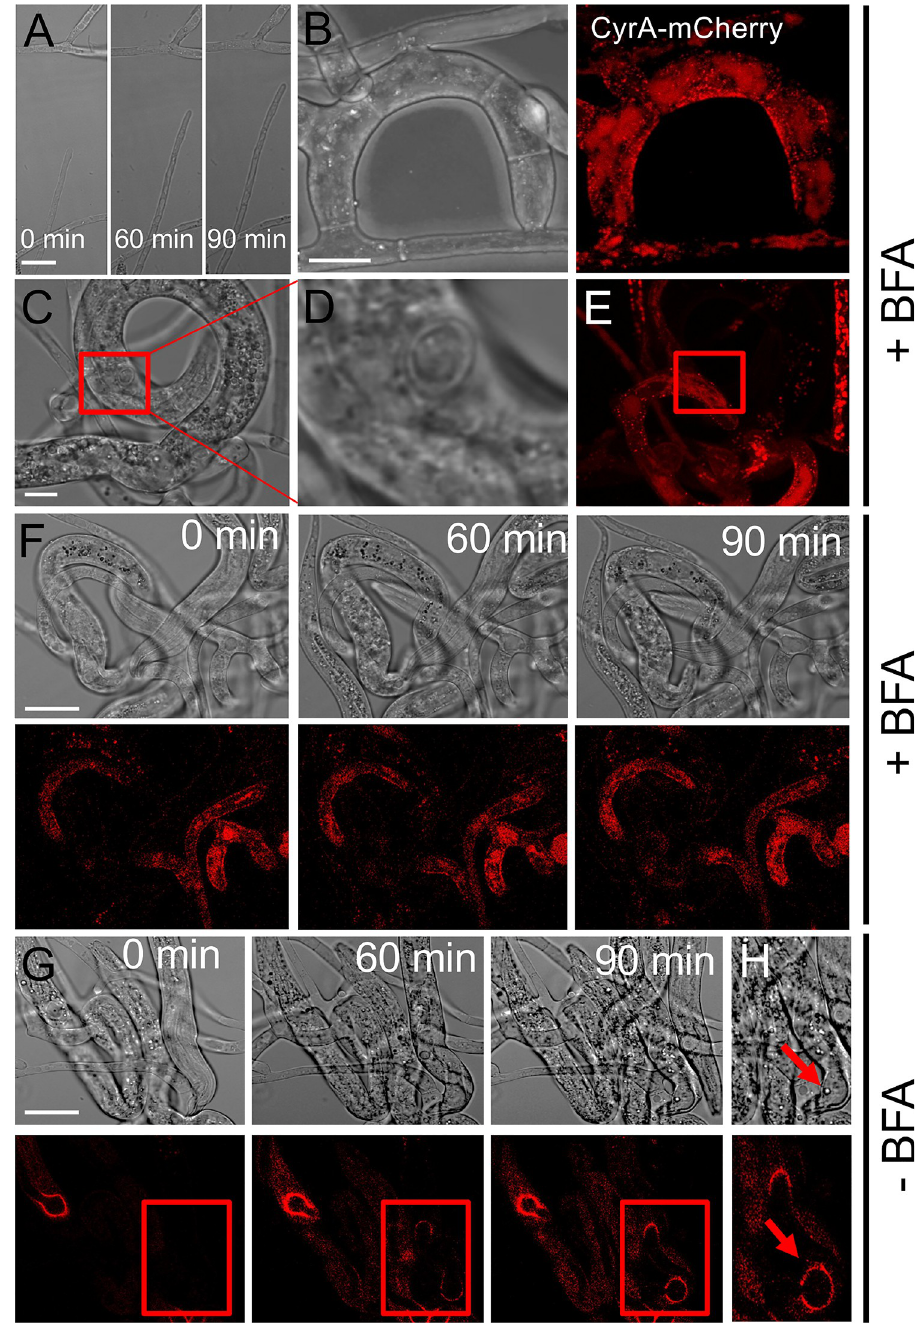
Fig 4. Brefeldin A treatment inhibits penetration and CyrA accumulation at the infection bulb. (A) D . flagrans expressing cyrA(p) :: cyrA :: mCherry (sNH65) was co-incubated with C . elegans on thin LNA slides for 24 h at 28˚C. A 1 cm square was cut from the agar and placed upside down onto a 5 μ l drop of 50 μ g/ml BFA. A hypha after 60 and 90 min. (B) CyrA-mCherry localization in the trap after BFA treatment. (C) Observation of an infection site in the DIC channel (enlargement in (D) ). The red box indicates the penetration site. (E) Localization of CyrA-mCherry after BFA treatment and penetration. The red box indicates the penetration site. (F, G) Time course of infection bulb formation and CyrA-mCherry distribution in the presence (F) and the absence (G) of BFA. (H) Enlargement of the formed infection bulbs after 90 min. The arrow points to the entry point of the fungus. Scale bars = 10 μ m.